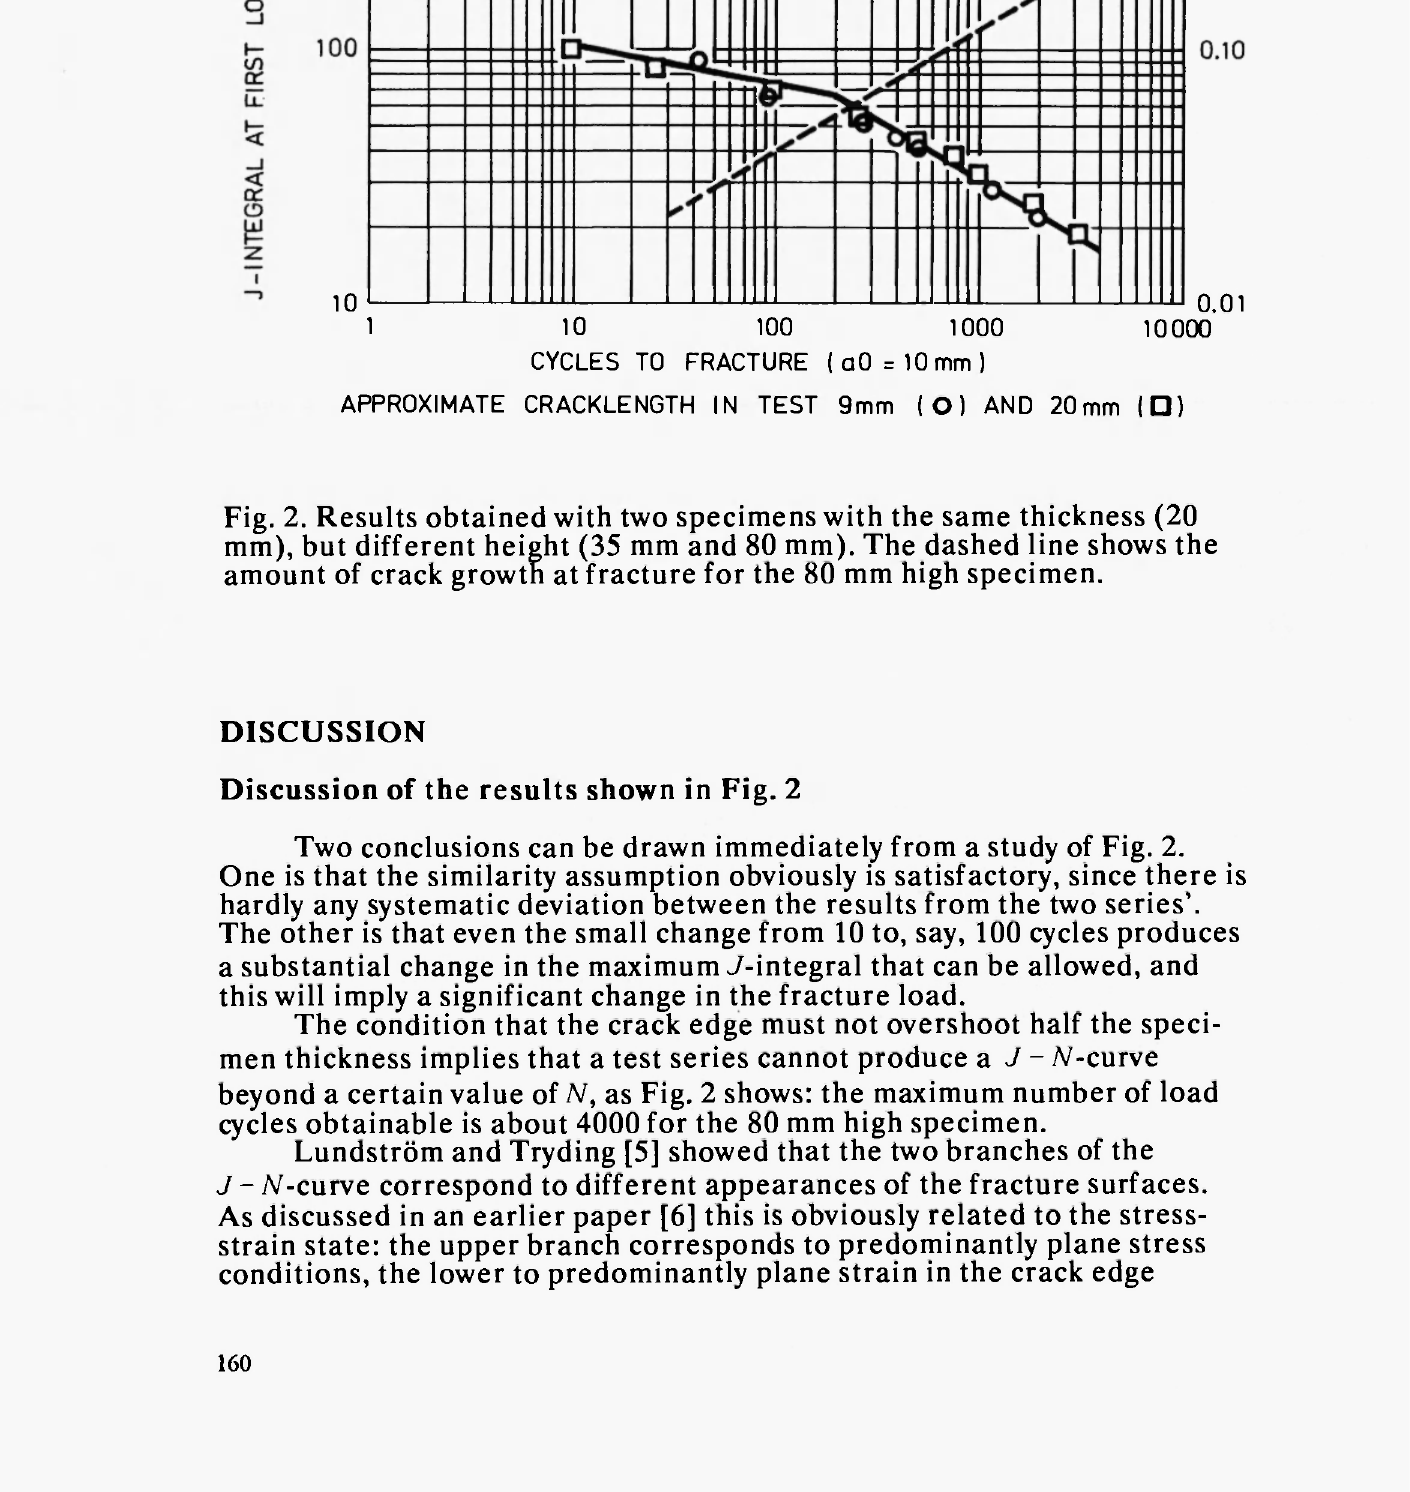
Fig. 2. Results obtained with two specimens with the same thickness (20 mm), but different height (35 mm and 80 mm). The dashed line shows the amount of crack growth at fracture for the 80 mm high